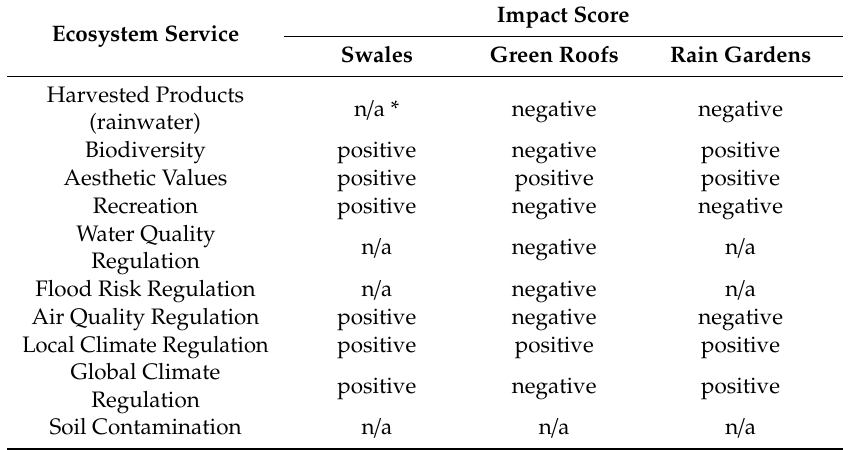
Table 1. Natural capital impact scores of blue-green infrastructure options on ecosystem